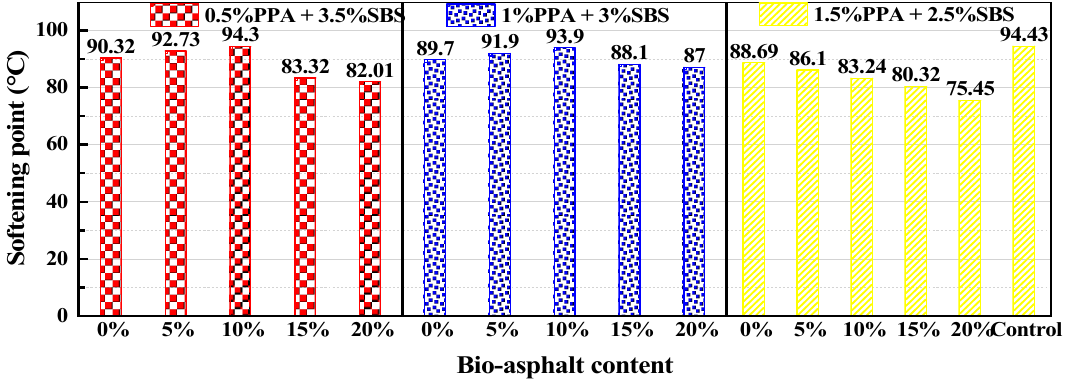
Figure 5. Test results for the softening point.